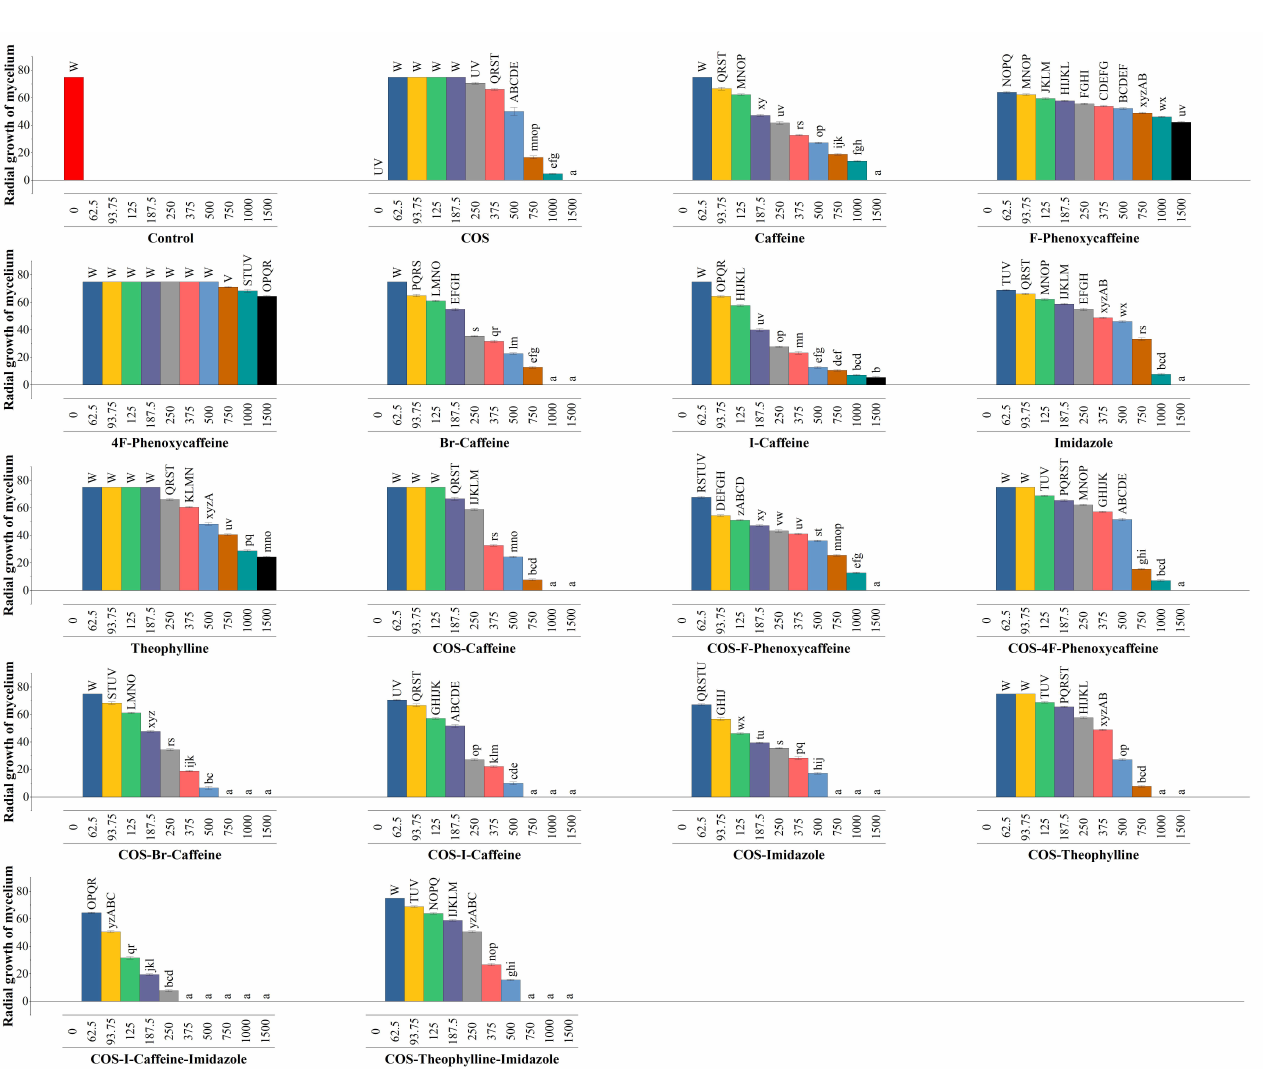
Figure 5. Mycelial growth inhibition of D. viticola by caffeine, its derivatives, imidazole, and theo- phylline, their respective COS–conjugated complexes, and some selected ternary combinations with imidazole at different concentrations (ranging from 62.5 to 1500 µ g mL − 1 ). Error bars repre- sent standard deviation. Treatment–concentration combinations accompanied by the same letters are not significantly different at p < 0.05 according to Tukey’s HSD test after a two-way ANOVA (Tukey’s HSD lettered grouping follows the sequence a–z, A–W, where ‘a’ indicates the group of treatment–concentration combinations with the highest efficacy and ‘W’ the group of least effective treatment–concentration